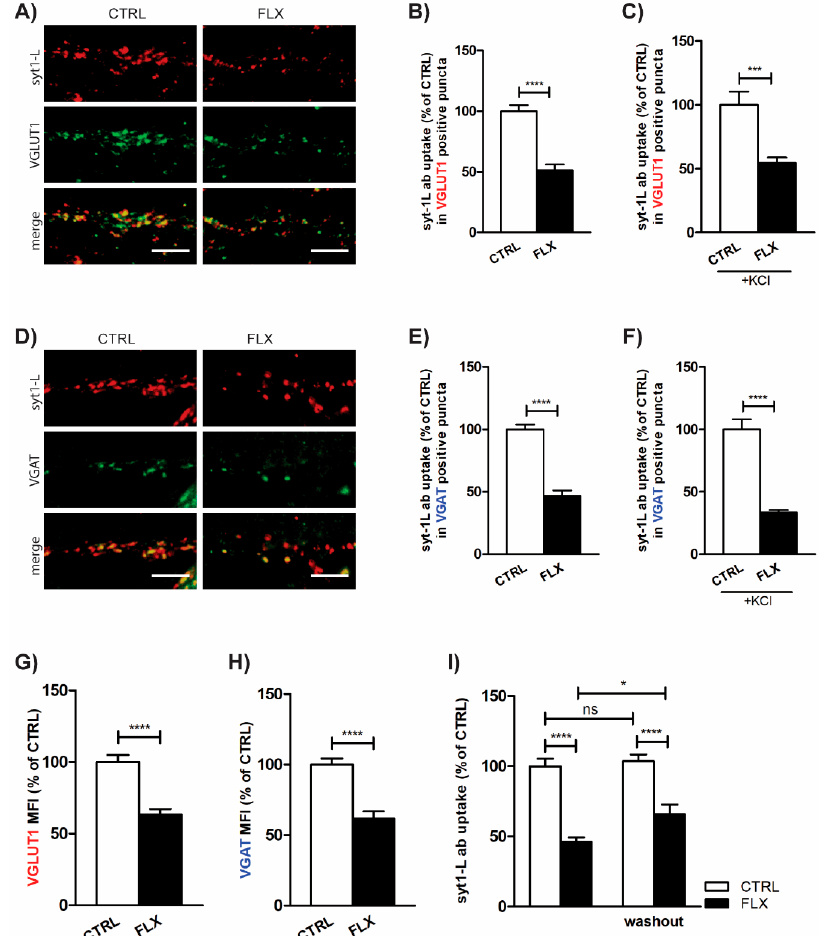
Figure 2. FLX decreases both glutamatergic and GABAergic neurotransmission. ( A ) Representative images of cortical neurons incubated with FLX (100 µM: 90 min) or control solution and stained with syt1-L ab (red) and marker for excitatory synapses (vesicular glutamate transporter 1, VGLUT1, green). Statistical quantification of the intensity of syt1-L ab uptake in puncta positive for VGLUT1 driven by both spontaneous ( B ) and KCl-evoked network activity ( C ) ( n = 25 CTRL cells; n = 23 FLX-treated cells). ( D ) Representative images of cortical neurons incubated with FLX (100 µ M: 90 min) or control solution and stained with syt1-L ab (red) and marker for inhibitory synapses (vesicular GABA transporter, VGAT, green). Statistical quantification of the intensity of syt1-L ab uptake in puncta positive for VGAT driven by spontaneous ( E ) and KCl-evoked network activity ( F ) ( n = 29 CTRL cells; n = 24 FLX-treated cells). ( G ) Quantification of VGLUT1 immunoreactivity in CTRL ( n = 35) and FLX-treated cells ( n = 33) along 20 µ m of proximal dendrite. ( H ) Quantification of VGAT immunoreactivity in CTRL ( n = 41) and FLX-treated cells ( n = 31) along 20 µ m of proximal dendrite. ( I ) Quantification of syt1-L ab uptake along 20 µ m of proximal dendrite 24 h after FLX washout ( n = 29 CTRL; n = 23 FLX; n = 31 CTRL / wo; n = 24 FLX / wo). In all graphs, values are expressed as means ± SEM and normalized to the mean intensity value in the control group. Statistical significance was assessed by Student’s t -test ( B , E , F ), Mann–Whitney test ( C , G , H ), and two-way ANOVA followed by Bonferroni multiple comparison test ( I ); ** p < 0.01, *** p < 0.001 **** p < 0.0001. Scale bar, 5 µm.